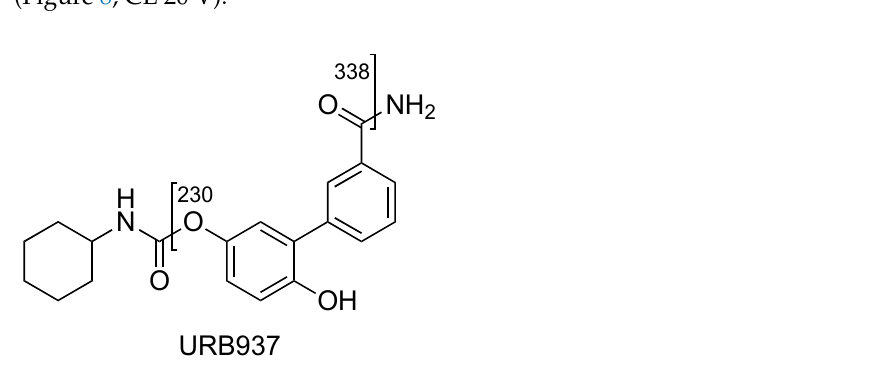
Figure 7 . Representation of alkali metal peaks of URB937 compound. The most abundant ion at m / z 230 results from the loss of cyclohexyl isocyanate (Figure 8, CE 20 V).